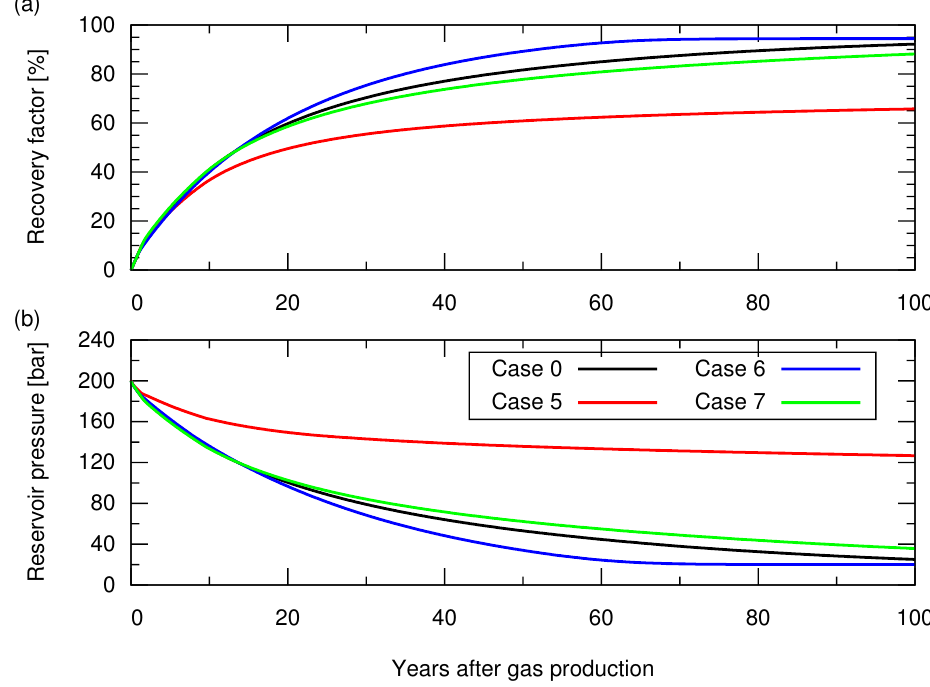
Figure 7. Results of the natural depletion simulations for case 0 and cases 5 to 7. The descriptions of these cases are shown in Table 2. ( a ) Hydrocarbon gas recovery factor; ( b ) Reservoir